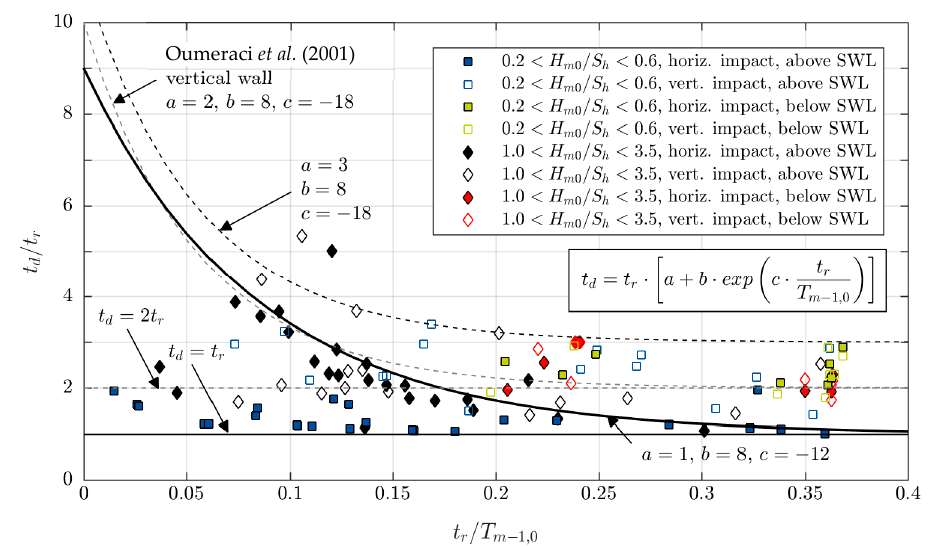
Figure 7. Correlation of the dimensionless impact duration t d / t r and the dimensionless impact rising time t r / T m– 1,0 at stepped revetments compared to findings for vertical walls. Given trend lines following Equation (5) represent upper envelopes of the findings. Straight horizontal lines represent the corresponding lower envelope line.